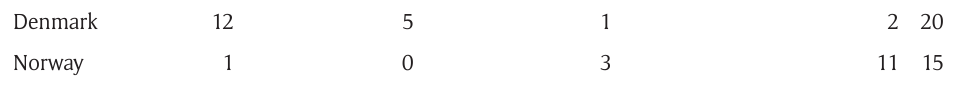
Table 3: Which meetings are best for constructive and solution-based